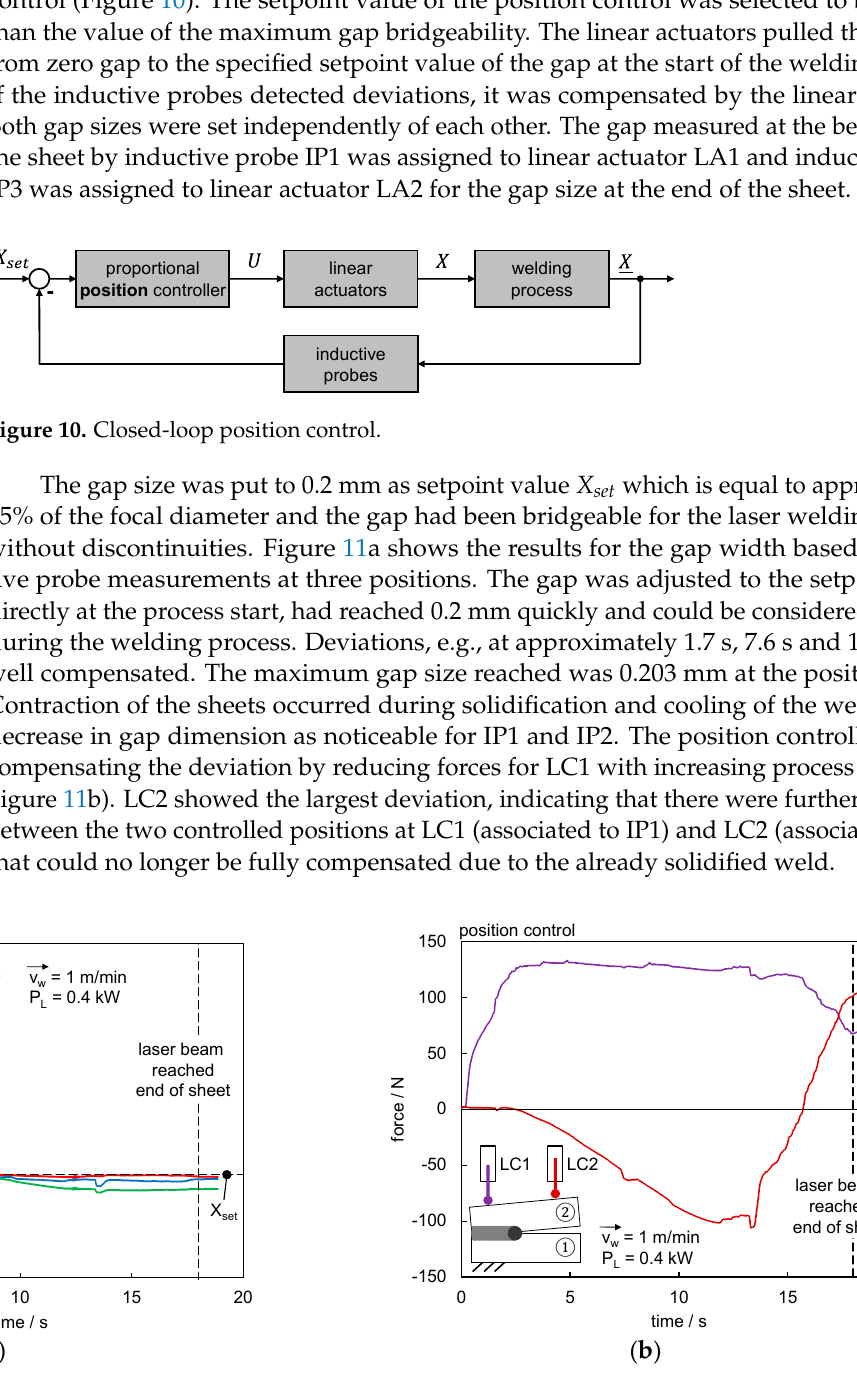
Figure 9. Force measurement of a rigid clamping for an uncontrolled process (v w = 1 m/min, P L = 0.4 kW).